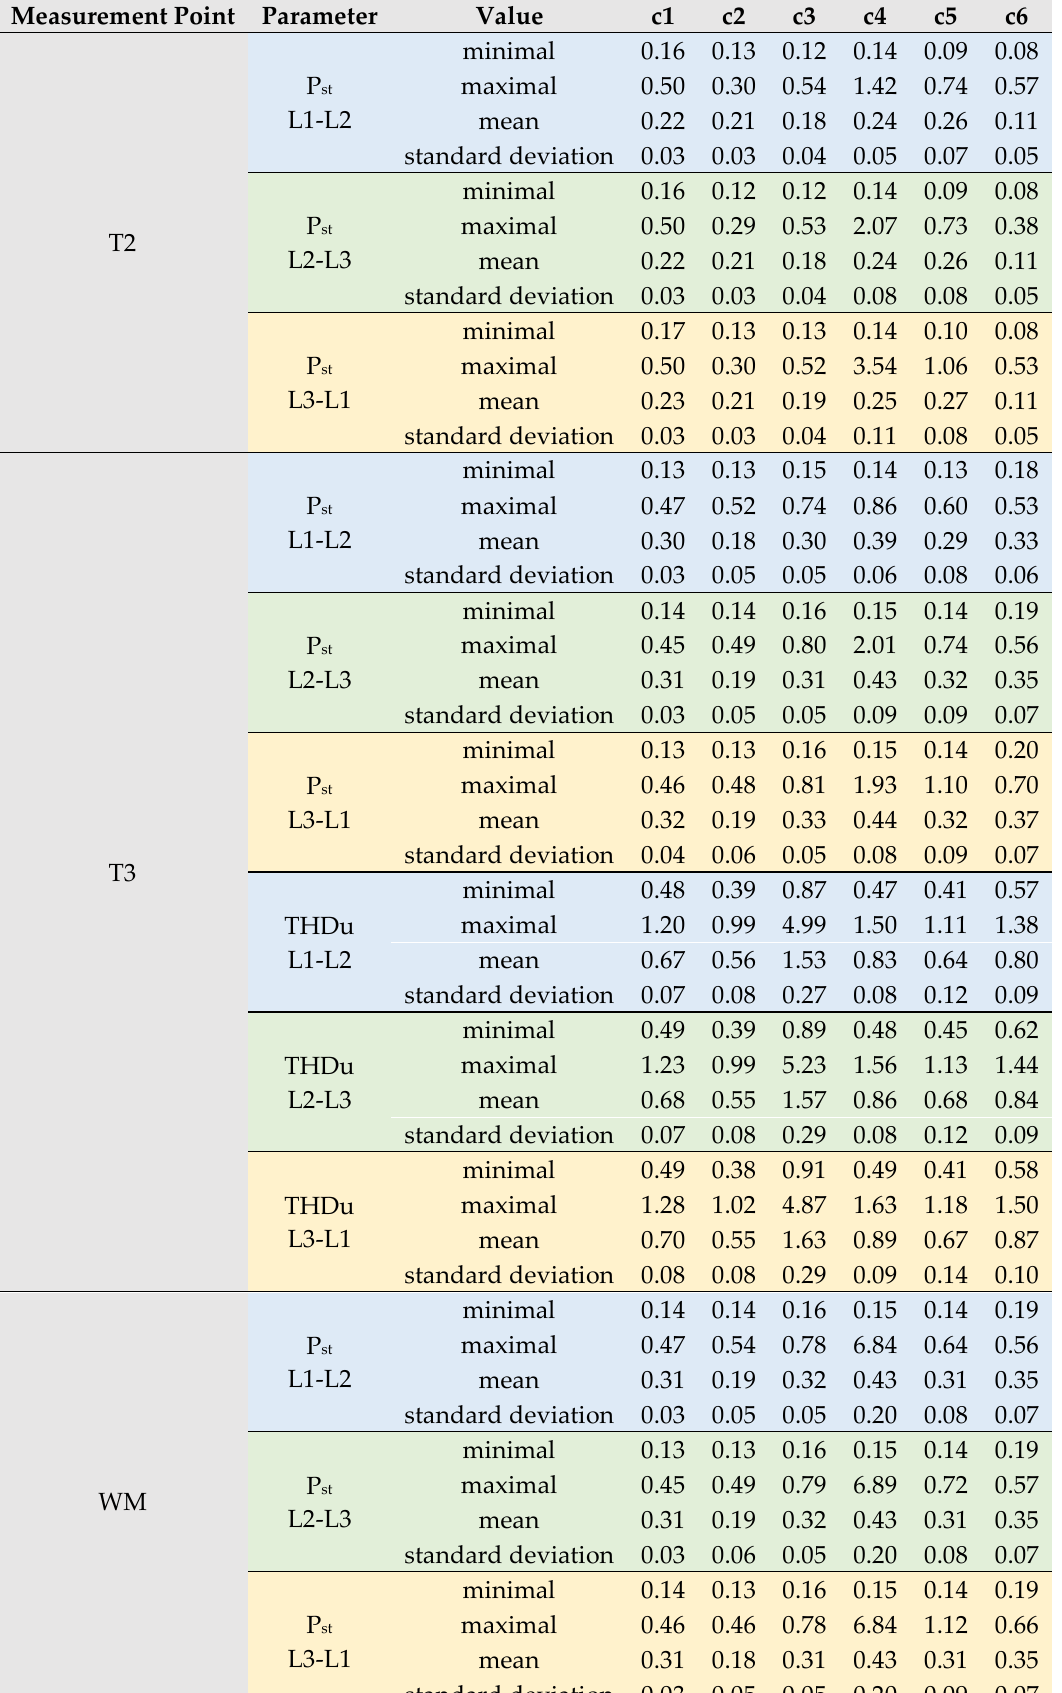
Table 2. Comparison of the PQ level for di ff erent clusters.